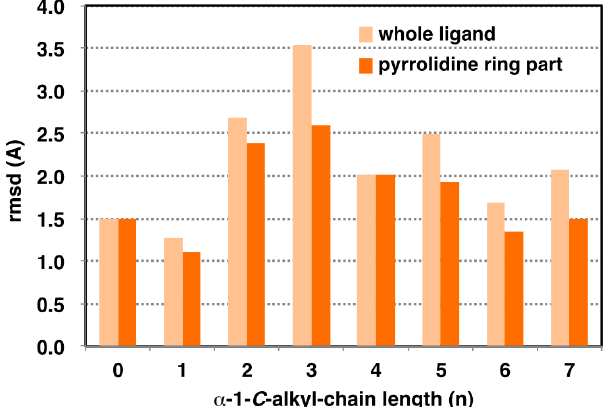
Figure 4. The binding poses of the LAB and α -1- C -alkyl-LAB derivatives extracted from the molecular dynamics (MD) trajectory: ( a ) LAB, ( b ) α -1- C -methyl-LAB, ( c ) α -1- C -ethyl-LAB, ( d ) α -1- C -propyl-LAB, ( e ) α -1- C -butyl-LAB, ( f ) α -1- C -pentyl-LAB, ( g ) α -1- C -hexyl-LAB, ( h ) α -1- C -heptyl-LAB.